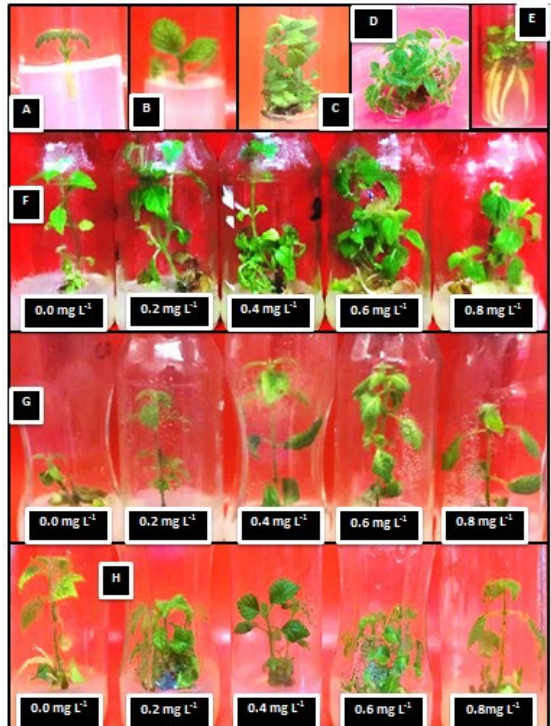
Figure 1. The effect of some heavy metals on the on big-sage (Lantana camara L.) growth in vitro. (A) and (B). Shoot tip Shoot multiplication on MS medium (C) and (D). supplied with 0.6 mg L-1 BA and 0.1 mg L-1 NAA after 8 weeks of culturing Rooted shoot on MS